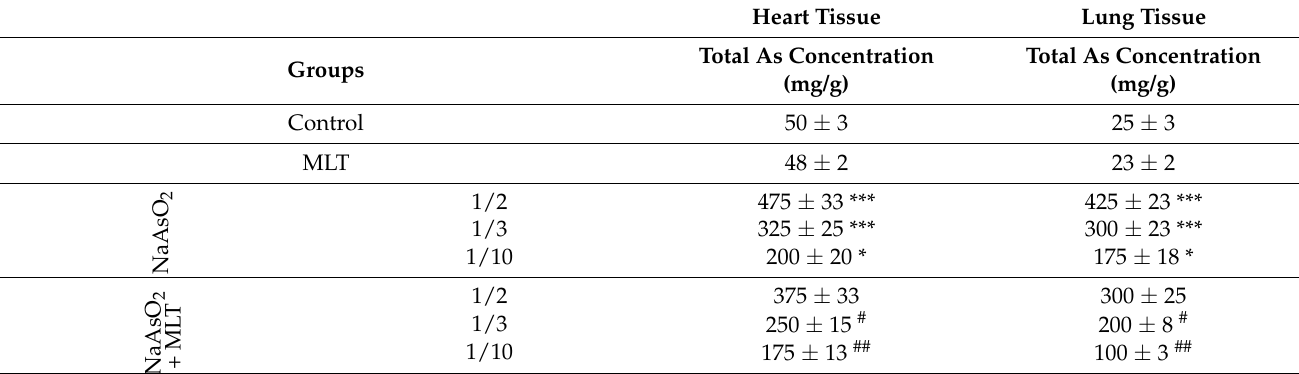
Table 1. Total As concentration in heart and lung